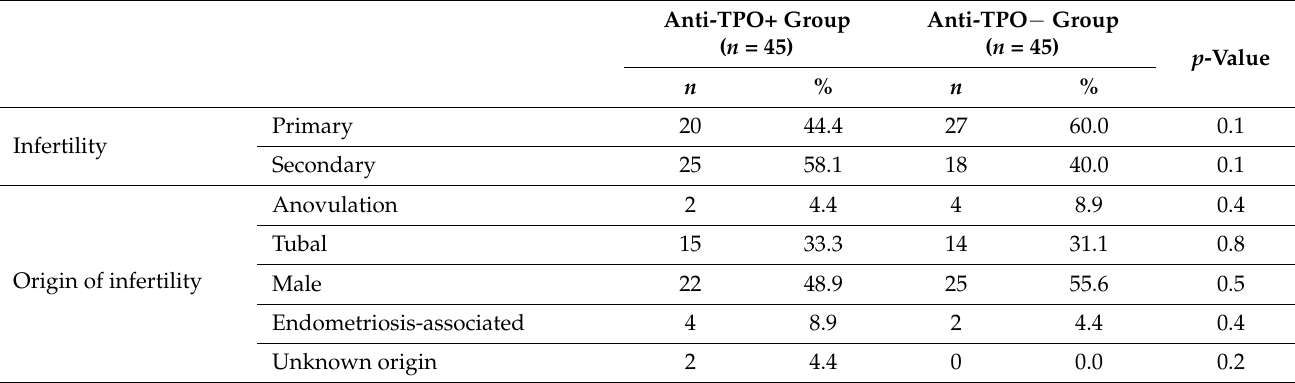
Table 2. Infertility causes within the groups.